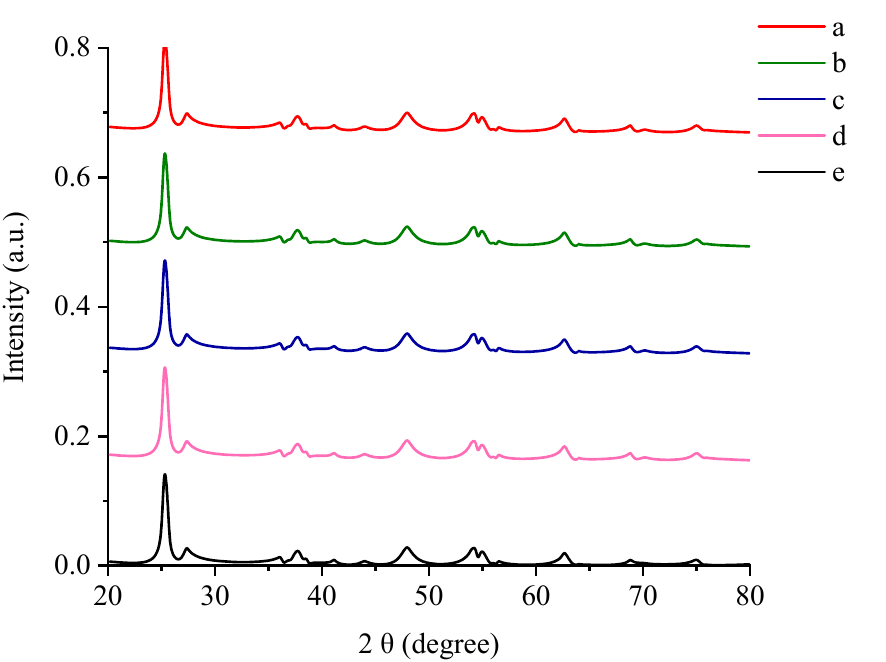
Figure 1. XRD: ( a ) titanium dioxide; ( b ) 0.6 wt %; ( c ) 1.2 wt %; ( d ) 1.8 wt %; ( e ) 2.4 wt % erbium ions/titanium dioxide.